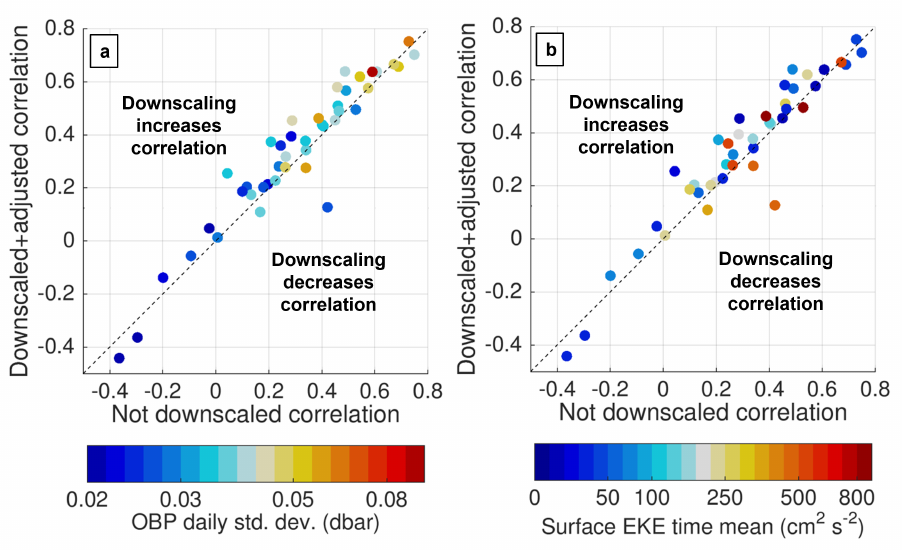
Figure 5. Scatter plots of correlations between in situ and GRACE-based OBP, 3–12 month timescales. The x-axis indicates the correlation without downscaling of the GRACE data, the y-axis indicates the correlation with the depth-adjusted downscaled GRACE data, with the dashed diagonal line indicating zero improvement. Color shading of the circles indicates ( a ) the standard deviation of OBP at each site in daily averages from ECCO2 CS510 without further temporal filtering, and ( b ) the time mean surface eddy kinetic energy at the site, computed from gridded CMEMS altimetry data.